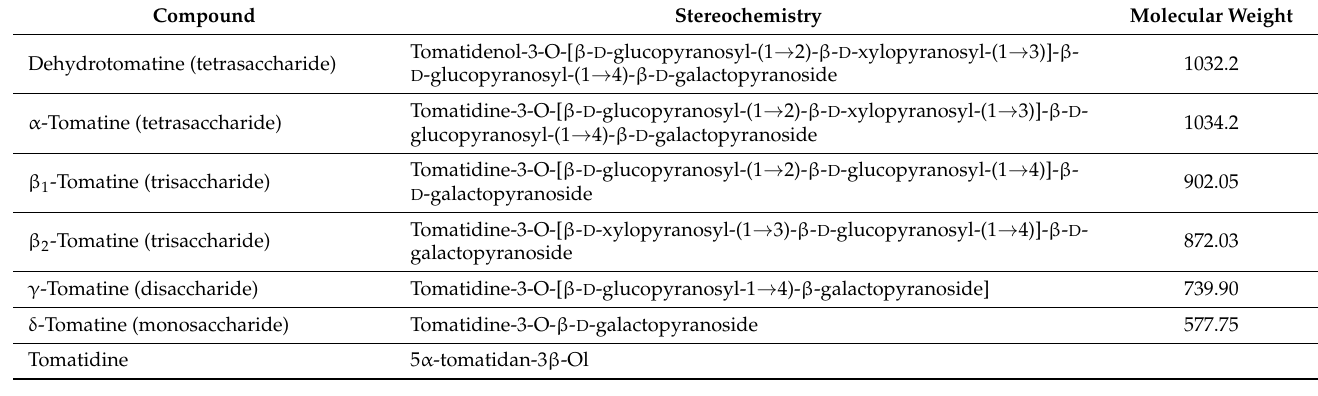
Table 1. Stereochemical configurations of the identical tetrasaccharide (lycotetraose) side chains of dehydrotomatine and α -tomatine attached to the aglycones tomatidenol and tomatidine, respec- tively, and of the hydrolysis products from the two isomers, some of which were observed in the mass spectra.